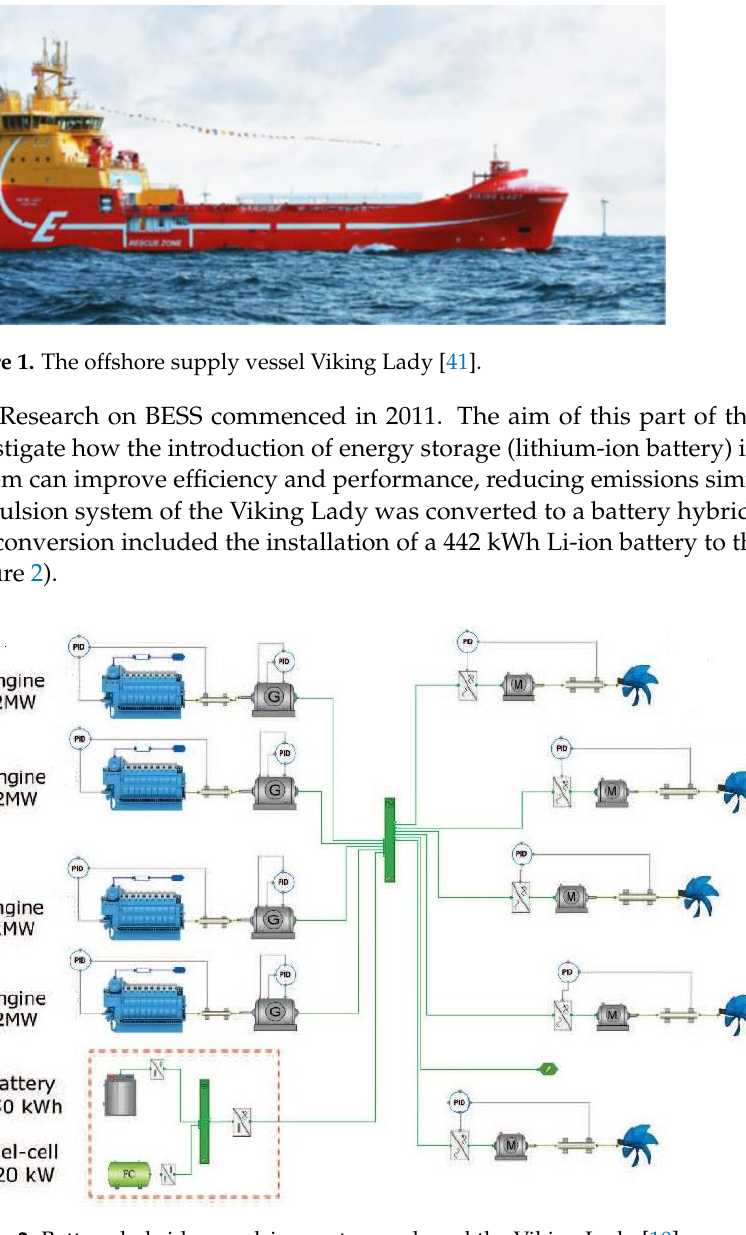
Figure 2. Battery-hybrid propulsion system on board the Viking Lady [10].